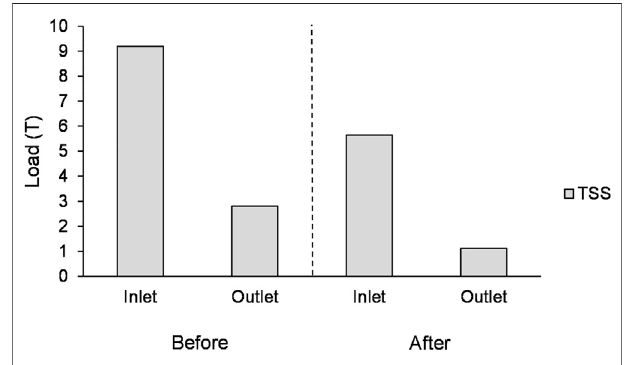
FIGURE 7 | Event fl ow sum TSS loads at the CW inlet and outlet, before and after maintenance.